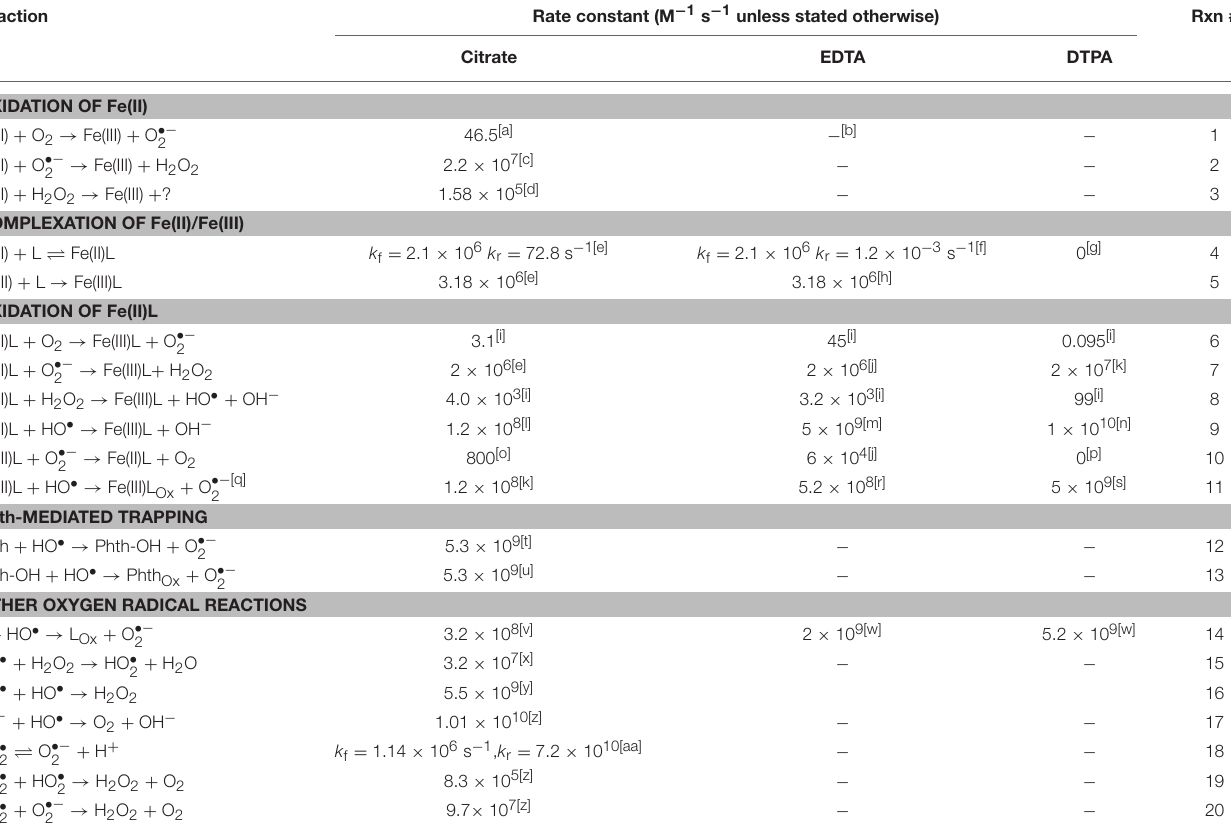
TABLE 1 | “Fe(II)L” kinetic model for Fe(II)L oxidation. Reaction Rate constant (M − 1 s − 1 unless stated otherwise) Rxn # Citrate EDTA DTPA OXIDATION OF